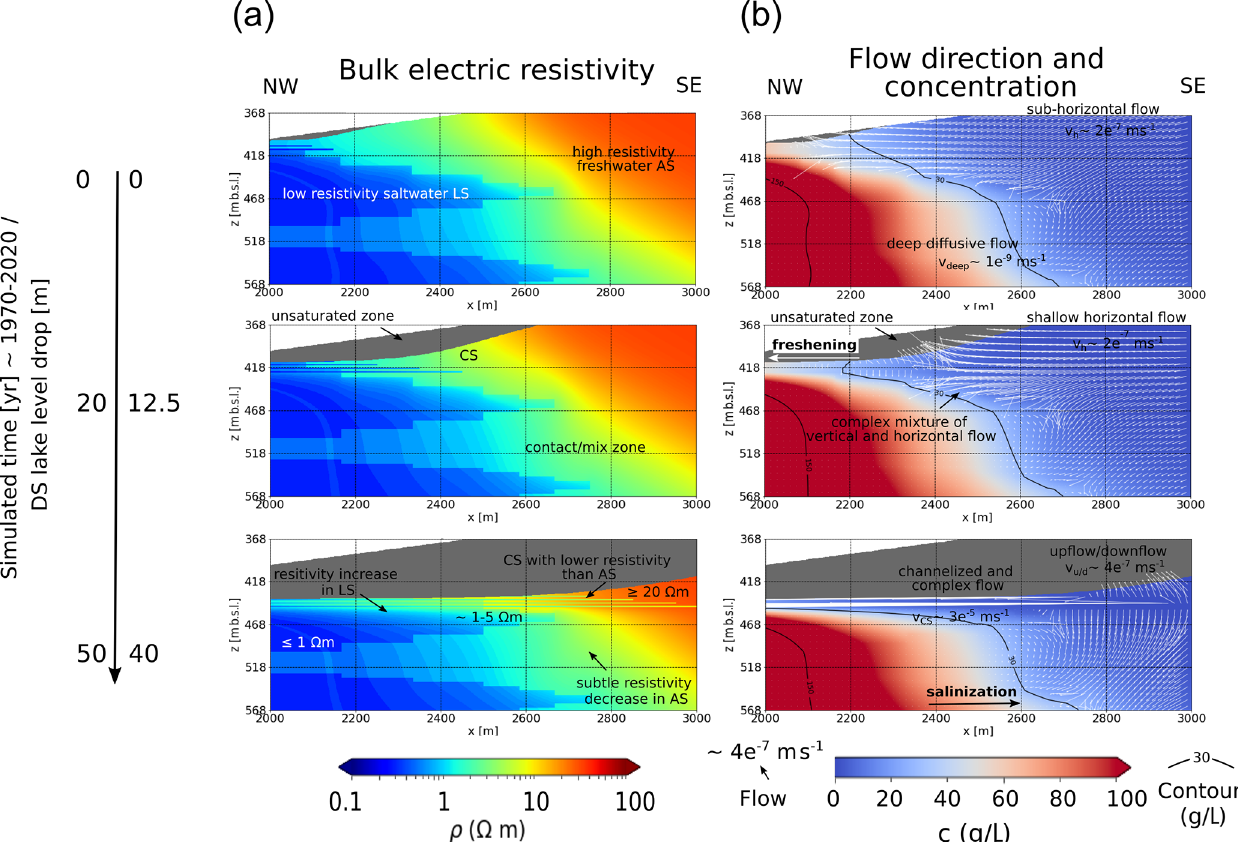
Figure 15. Close-up views of the model alluvium–mud contact area. (a) Simulated bulk electric resistivity. (b) Flow direction, typical flow values and salt concentration. Contours of 150 and 30gL − 1 are indicated. LS stands for lacustrine sediments, AS are the alluvial fan sediments and CS is the conduit system. Note the grid to assist